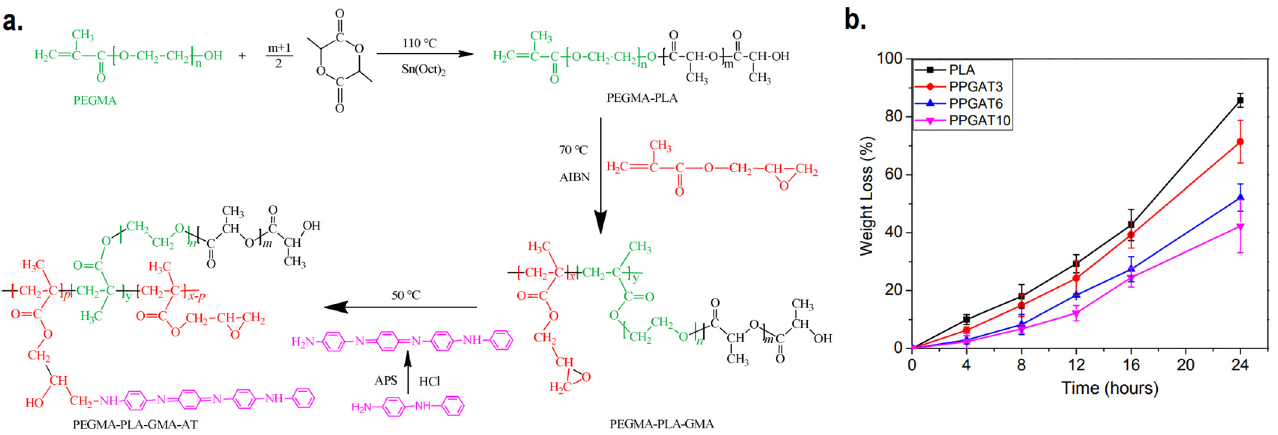
Figure 5. ( a ) Synthesis route of PEGMA-PLA-GMA-AT biodegradable conductive polymer. ( b ) Biodegradability of the copolymer with various ratio of PLA:aniline tetramer. Adapted with permission from [94] . Copyright (2016) Royal Society of Chemistry.